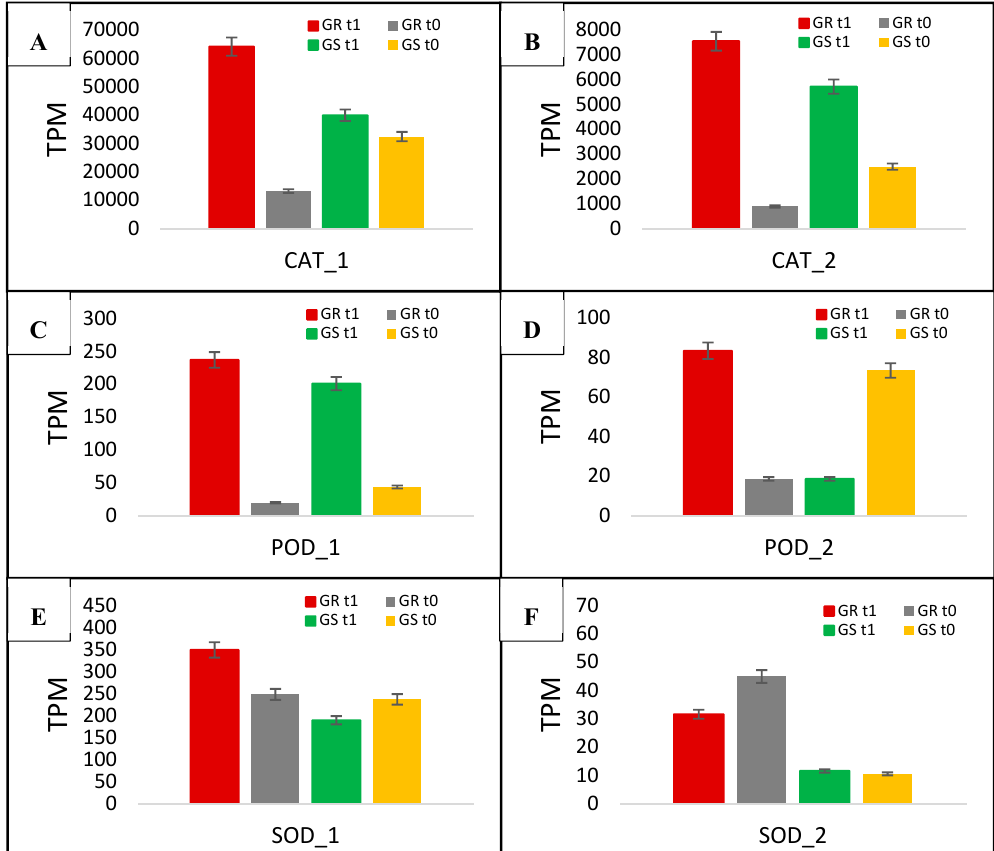
Figure 8. C. bonariensis transcriptome expression analysis (transcript reads per million mapped reads—TPM) of a two catalase (CAT — A and B), Peroxidase (POD — C and D), and superoxide dismutase (SOD — E and F) genes. GR: glyphosate-resistant biotype; GS: glyphosate-sensitive biotype. t0: without glyphosate treatment; t1: with glyphosate treatment — RNA was obtained from plants collected at several timepoints up to 288 h after treatment and pooled. Intervals indicate the standard error.